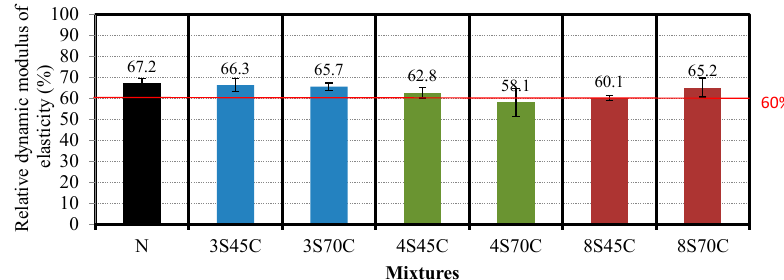
Figure 7. Results for the relative dynamic modulus of elasticity of the di ff erent mixtures after damage.